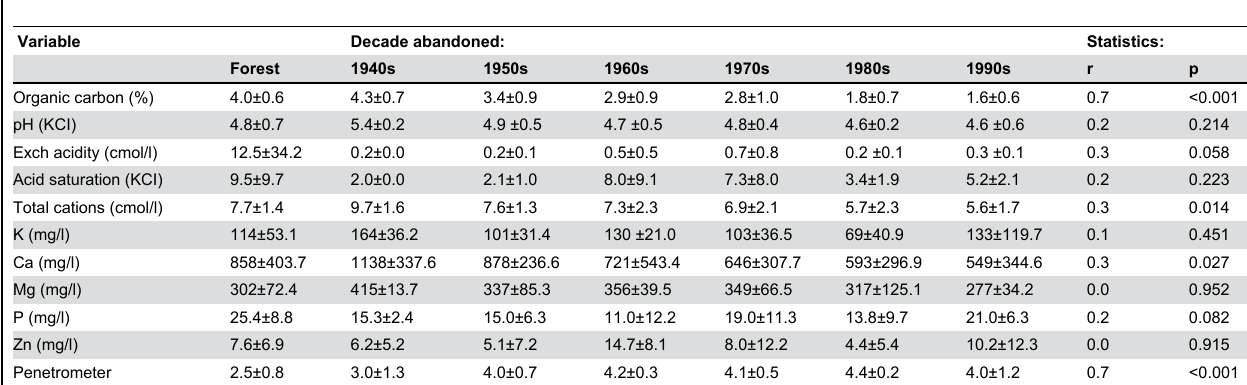
Table 3. Soil characteristics (mean + SE) with age of abandoned fields and uncleared forests (N = 55).